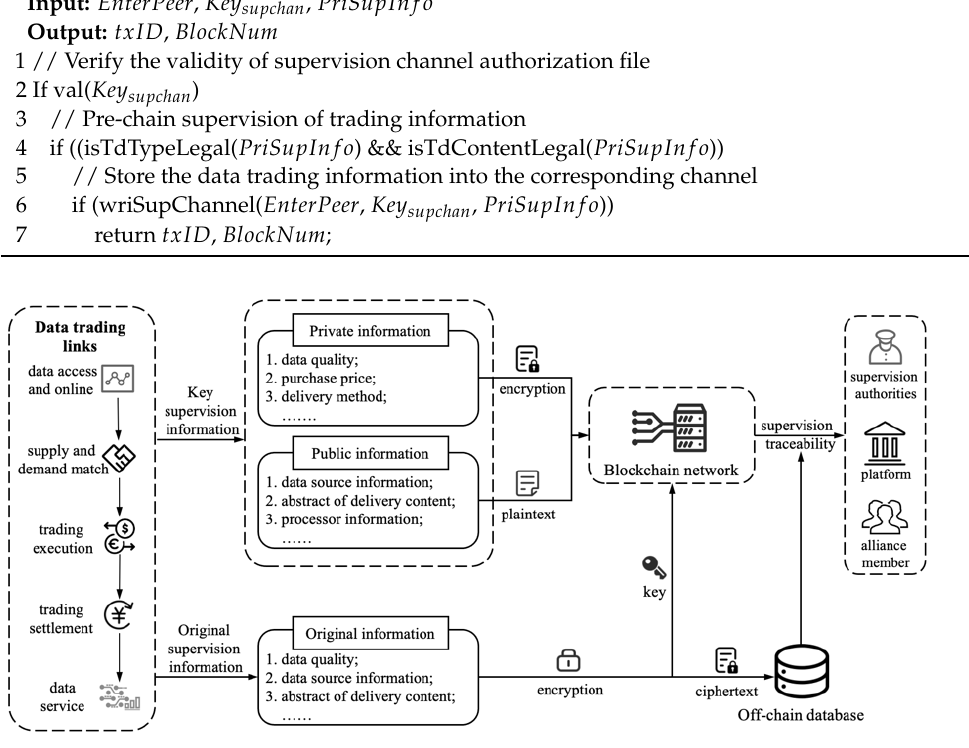
Figure 6. Data storage method for data trading supervision based on blockchain. Algorithm 1 : Smart contract for private supervision information on-chain